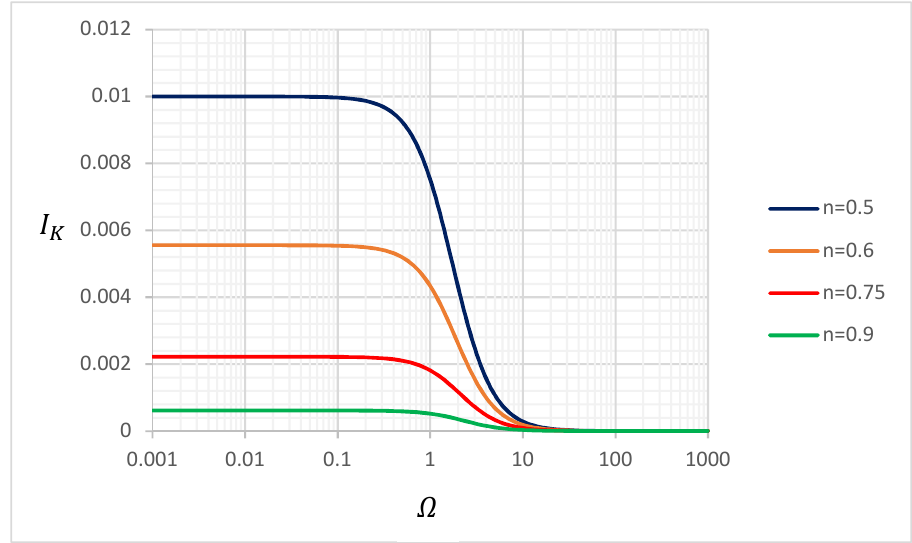
Figure 14. Dependency of the dispersion enhancement coefficient with dimensionless frequency and flow index for (cid:1844)(cid:1857) = 1 and (cid:2013) = 0.1 .